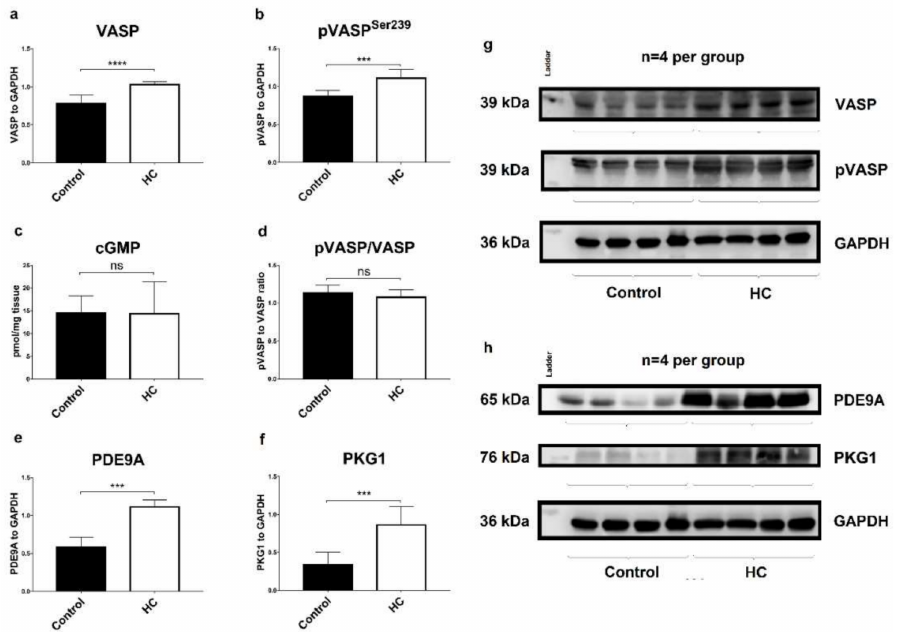
Figure 4. Outcomes of Western blot analyses and cGMP assays. Average band size for PDE9a was observed at around 65 kDa ( n = 4 per group). The expression of PDE9A was significantly higher in LV samples of HC animals in comparison to Controls (*** p < 0.001) ( e ). No significant differences were found in myocardial cGMP levels (expressed as pmol/mg of tissue, ELISA) of endpoint groups ( c ). Although both VASP and pVASP expression was significantly increased in HC group (*** p < 0.001 and **** p < 0.0001, respectively) ( a , b ), pVASP to VASP ratio was unchanged ( d ) and was well-correlated with cGMP levels. Expression of PKG1 enzyme was also elevated in HC group ( f ). Panels ( g , h ) show representative blots. Student’s t -test was used to estimate differences between the samples of HC and Control